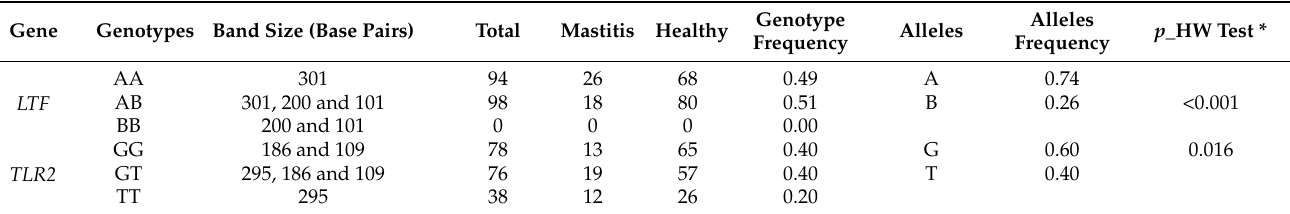
Table 3. The genotypic and allelic frequency of Lactoferrin and Toll-like receptor 2 gene. Gene Genotypes Band Size (Base